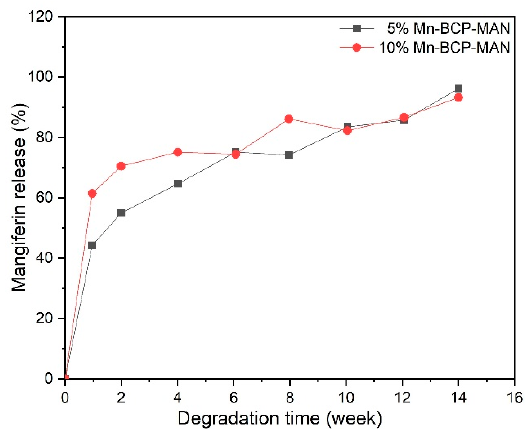
Figure 7. Release of mangiferin from the scaffolds.